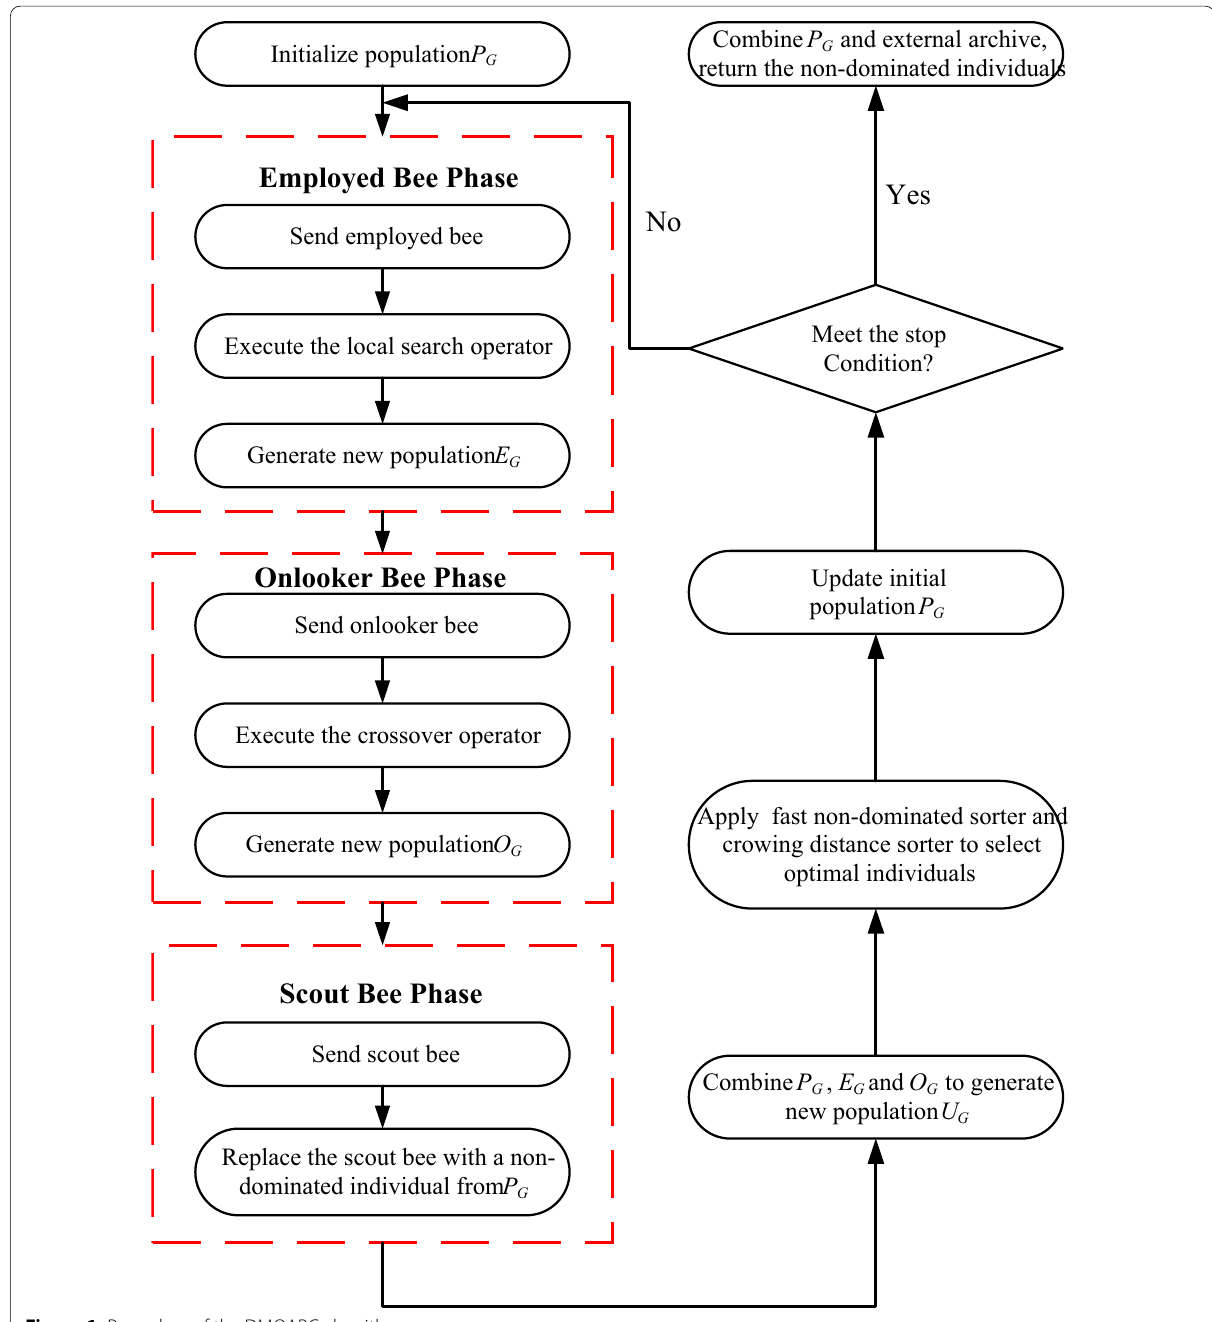
Figure 1 Procedure of the DMOABC